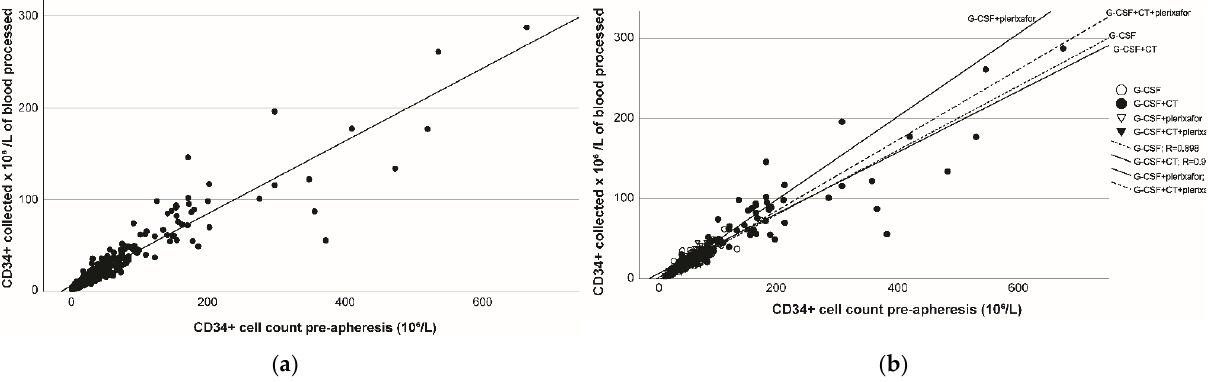
Figure 1. Correlations between pre-apheresis CD34+ cell count and CD34+ cells collected per liter of blood processed ( a ) overall and ( b ) by mobilization regimen. G-CSF, granulocyte colony-stimulating factor; CT,